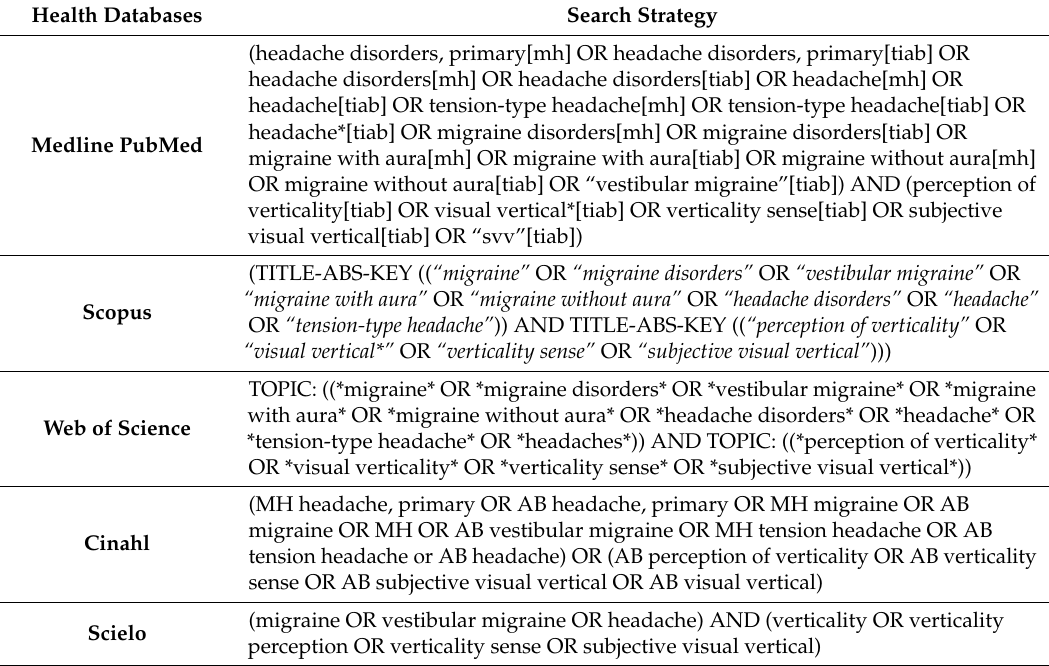
Table 1. Bibliographic search